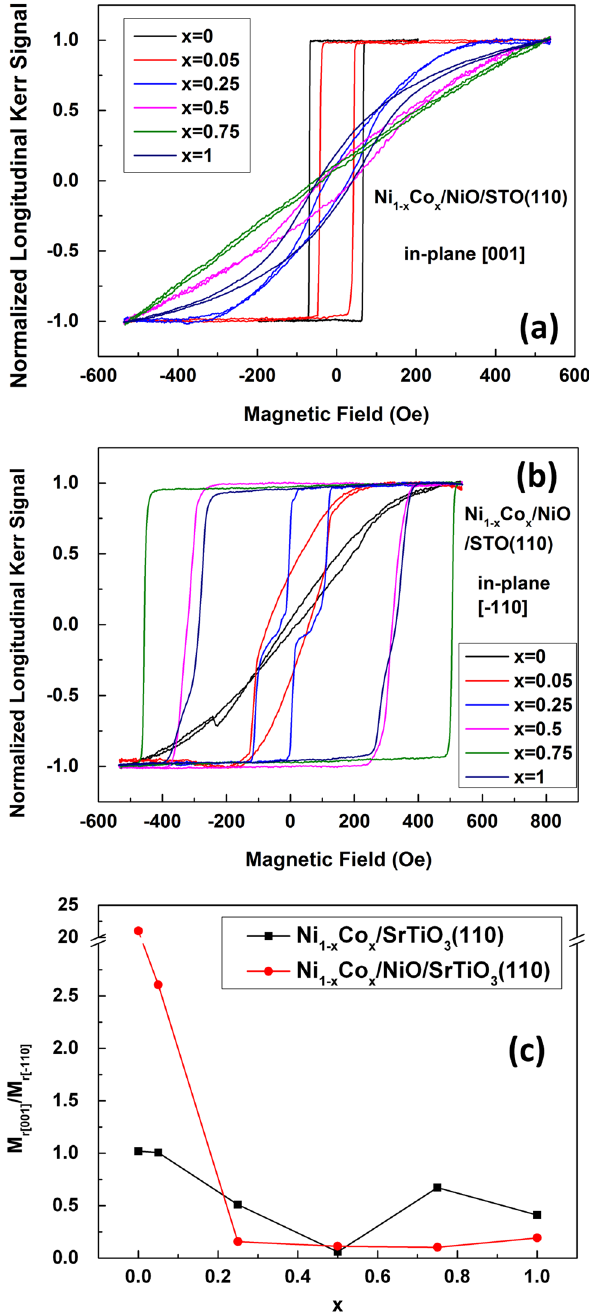
Fig. 5 Shifting of easy axis in Ni 1- x Co x (10nm)/NiO(12nm)/SrTiO 3 (110) heterostructure. MOKE measured M-H curves of different x in a